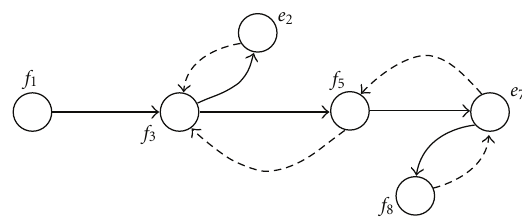
Figure 3: SDG of the bitank system. e 2 and e 7 are the square roots of levels in the two tanks respectively.